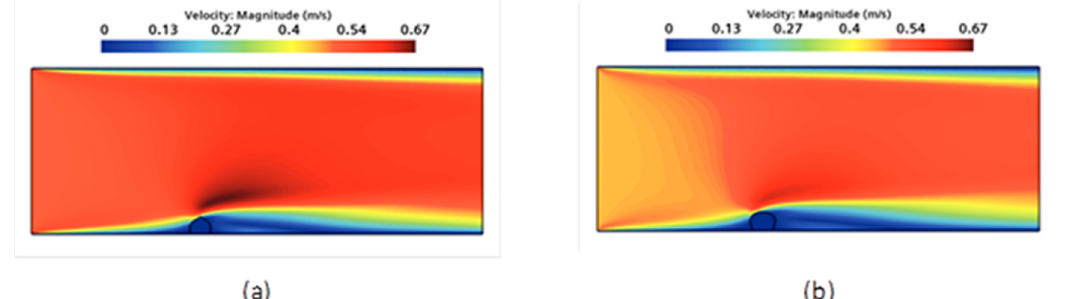
Figure 5. Velocity contour profile over a kernel extrapolated from the CFD simulation. With an airstream profile of 0.5 m/s note, the higher speed (dark red) over the point of the kernel of spinoso maize ( a ) compared to the control variety ( b ). This higher speed increases the turbulence intensity downstream enhancing the drying process.